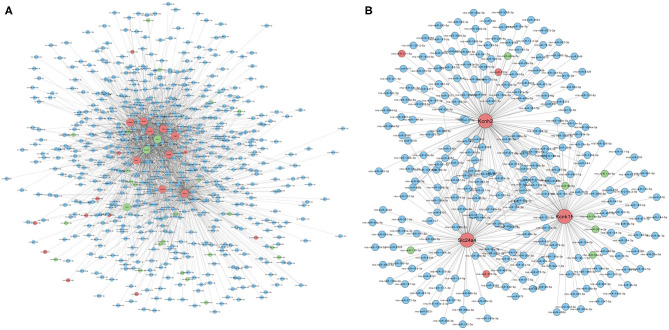
Prediction of microRNA–mRNA interaction. (A) Interaction network of 1,765 microRNAs with 12 ion channel-related mRNAs. (B) Interaction network of 396 microRNAs with three potassium ion channel-encoding mRNAs. Larger dots indicate mRNAs. Smaller dots indicated microRNAs. Red indicates upregulated mRNAs or microRNAs. Green indicated downregulated mRNAs or microRNAs. Blue indicates unchanged mRNAs or microRNAs.